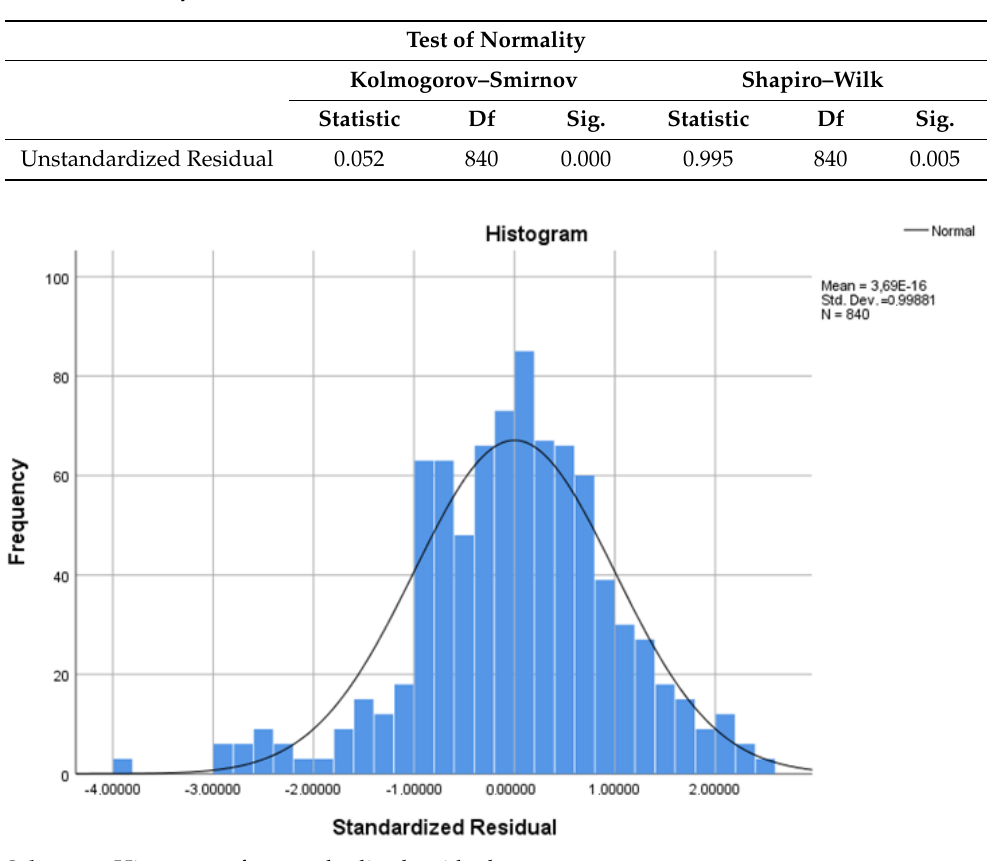
Table 9. Normality test unstandardized